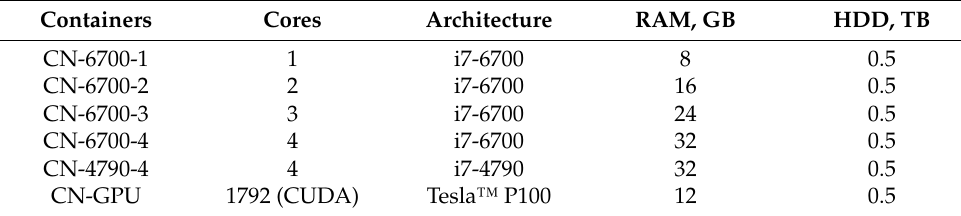
Table 2. Characteristics of